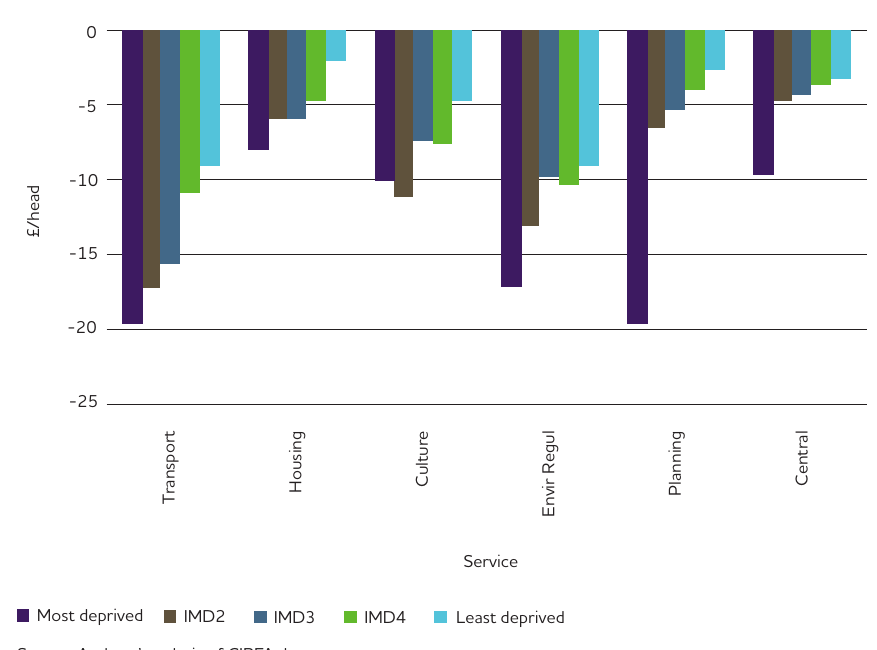
Figure 6: Real Budget Changes by Service for English District Councils by Deprivation Band, £/head,